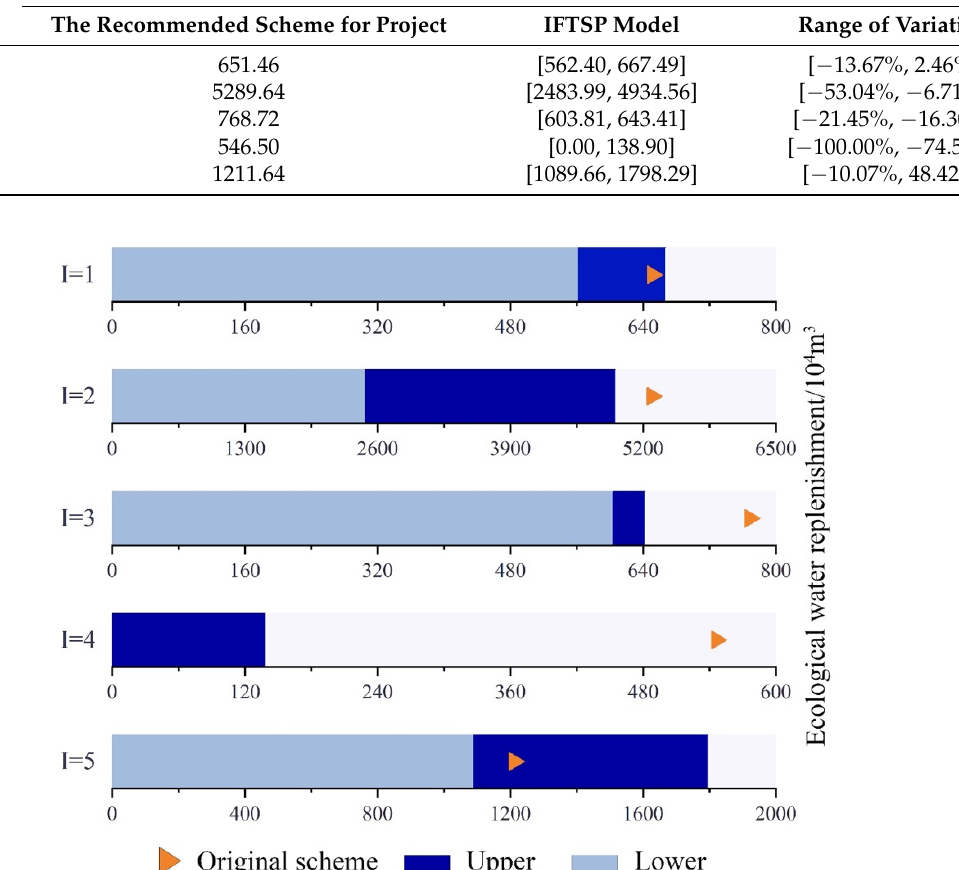
Table 1. Ecological replenishment water for each lake bubble in Boluo Lake National Nature Reserve. Lake Bubble